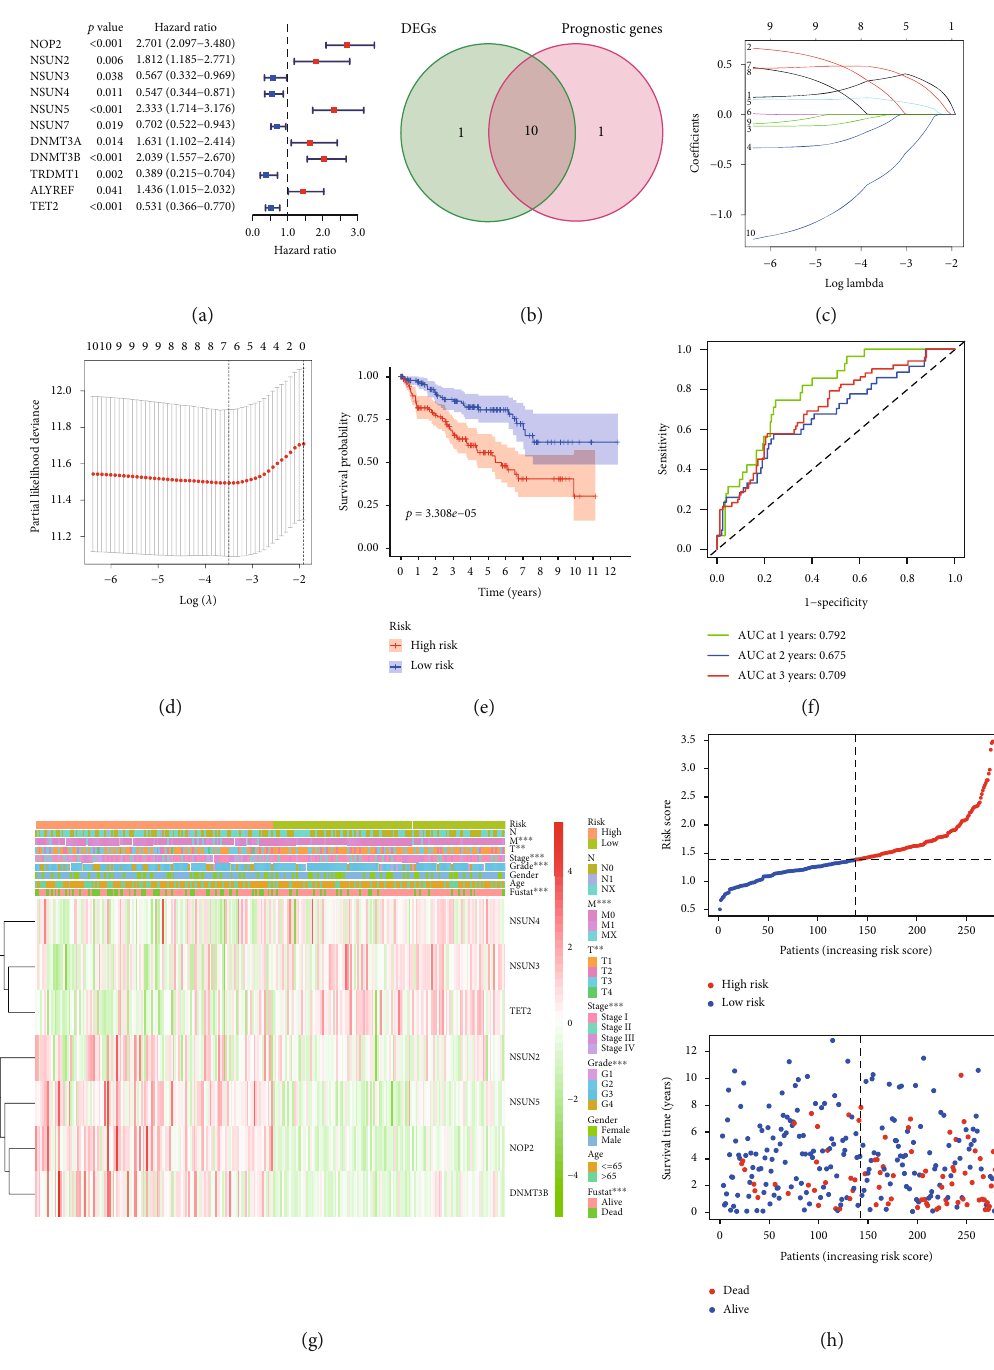
Figure 6: Construction and evaluation of the m 5 C RNA methylation-related prognostic risk signature in the training cohort. (a) Univariate Cox regression analysis results show the p values and hazard ratios (HR) with con fi dence intervals (CI) of the twelve m 5 C RNA methylation regulatory genes. (b) The Venn diagram between di ff erentially expressed genes and genes related to OS. (c, d) The 7 prognostic risk signature genes were selected by LASSO Cox regression analysis. (e) Kaplan-Meier survival curves show the overall survival (OS) rates of high-risk ( n = 135 ) and low-risk ( n = 132 ) ccRCC patients of the training cohort. The high-risk group shows shorter OS compared to the low-risk group. (f) The accuracy and reliability of the prognostic risk signature in determining the 1-year, 2-year, and 3-year survival outcomes of the high- and low-risk patients in the training cohort. (g) The expression heatmap of the seven prognostic risk-related m 5 C RNA methylation regulators in the high-risk (blue) and low-risk (pink) ccRCC patients of the training cohort. ∗∗ p < 0 : 01 ; ∗∗∗ p < 0 : 001 . (h) The distributions of risk scores of the high-risk (red) and low-risk (blue) ccRCC patients and corresponding survival time (the red dots represent the dead patients and the blue dots represent the alive patients) in the training